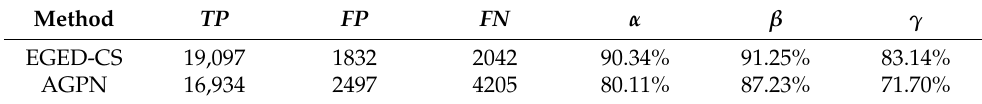
Table 4. Comparison of step-edge-detection accuracy